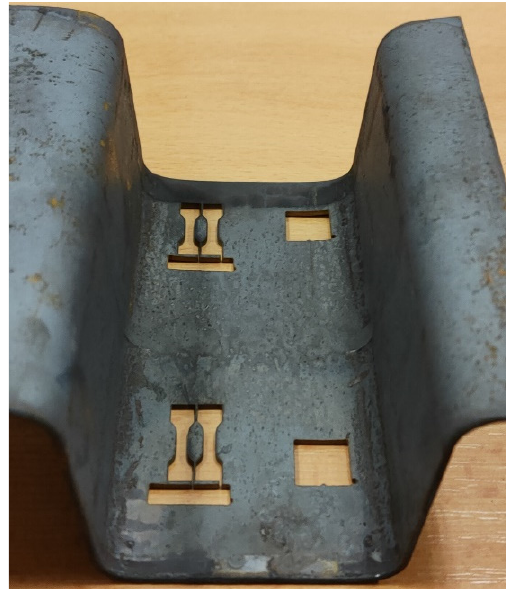
Figure 8. Position of mini tensile specimens on the omega profile product from cooled and heated part.